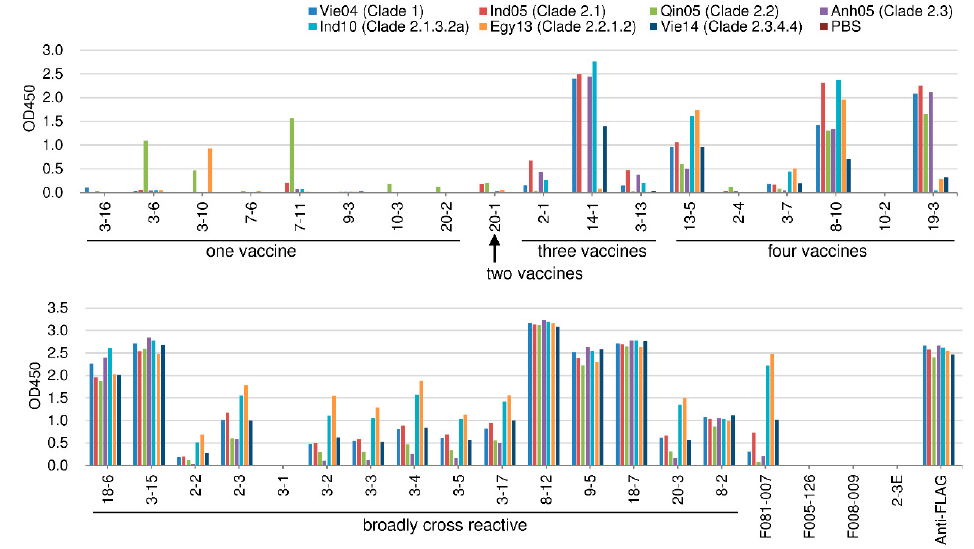
Figure 6. Binding activity of HI-negative clones to recombinant HA molecules derived from seven kinds of H5N1 viruses. Binding was measured by ELISA. F081-007 is an anti-H1 and -H5 HA antibody that was used as a positive control. F005-126 (an anti-H3 HA antibody) and F008-009 (an anti-influenza nucleoprotein antibody) were used as negative controls. Anti-FLAG antibody was used for detecting the FLAG tag that had been fused to the recombinant HA. The binding activity is shown as the optical density at 450 nm (OD450).